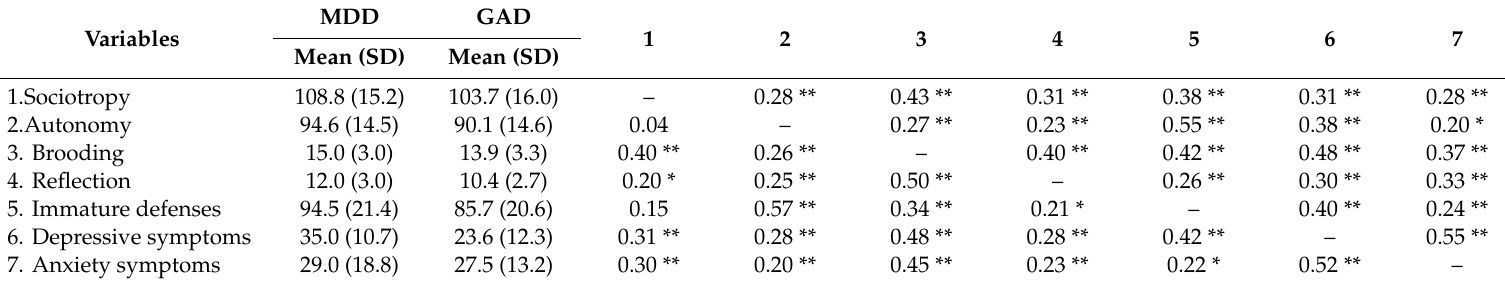
Table 1. Descriptive statistics and bivariate correlations of the Major Depressive Disorder (MDD) patients ( n = 119) and Generalized Anxiety Disorder (GAD) patients